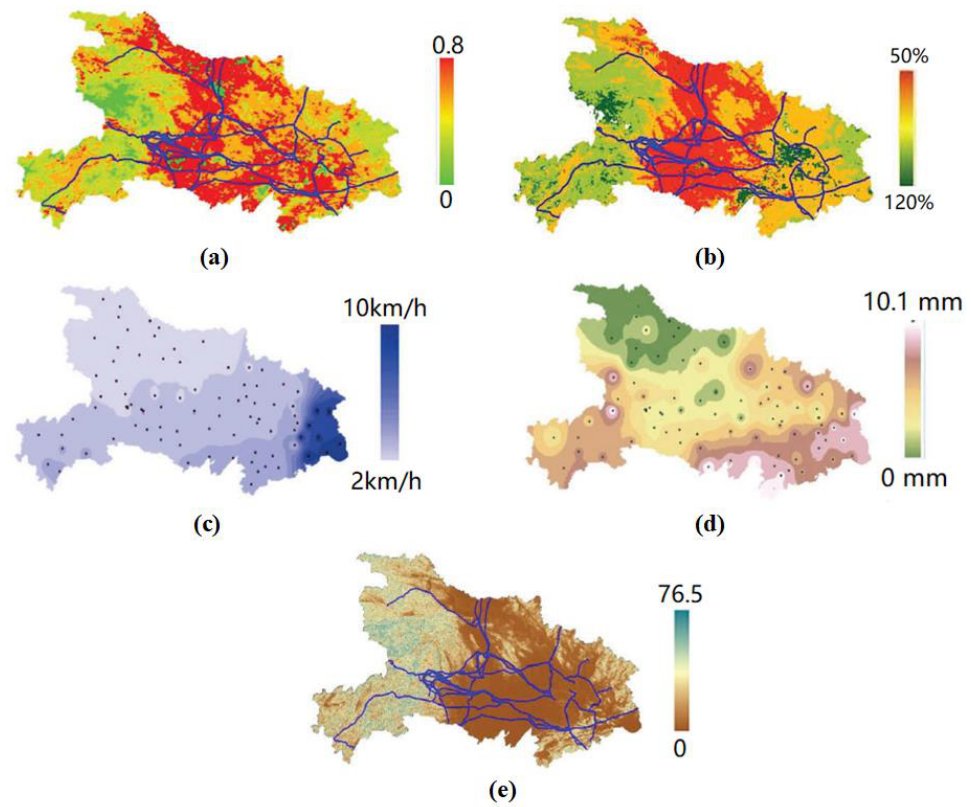
Figure 3. Examples of the real values of several input variables obtained in Hubei Province. ( a ) TVDI distribution in 1 October 2014; ( b ) FMC distribution in 1 October 2014; ( c ) average wind speed in 10 June 2014; ( d ) average precipitation in 10 June 2014; and ( e ) terrain slope.